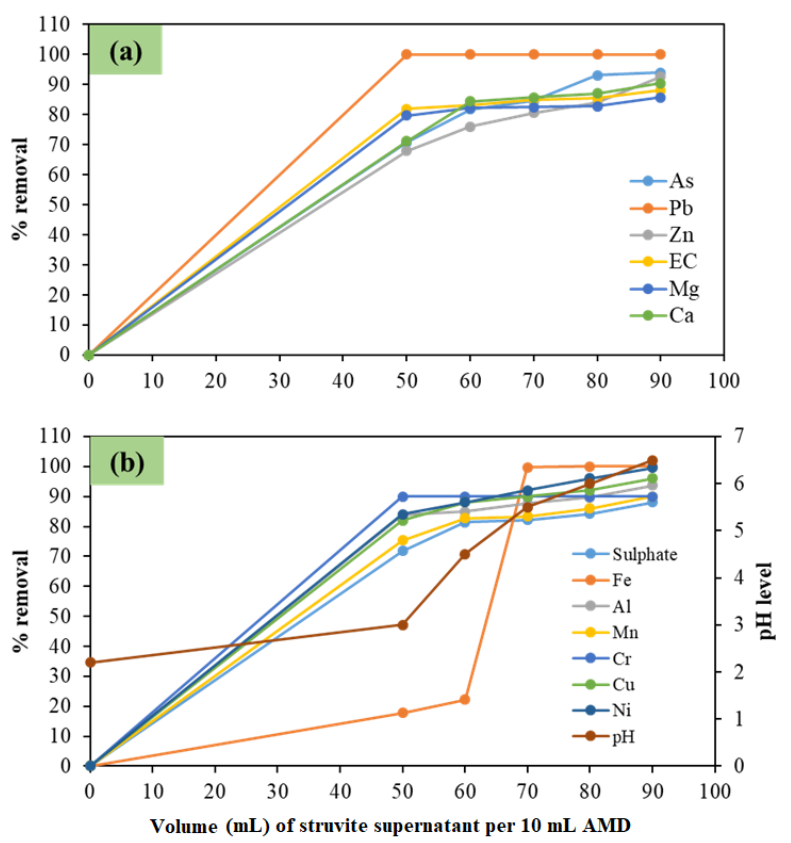
Figure 1. Changes in the pH and contaminants percentage (%) removal, i.e., ( a ) As, Pb, Zn, EC, Mg, and Ca; and ( b ) sulphate, Fe, Al, Mn, Cr, Cu, Ni, and pH, when using different AMD to struvite supernatant ratios. Conditions: 10 mL of AMD and varying mL of struvite -supernatant, room temperature, and 12 h equilibrium time.